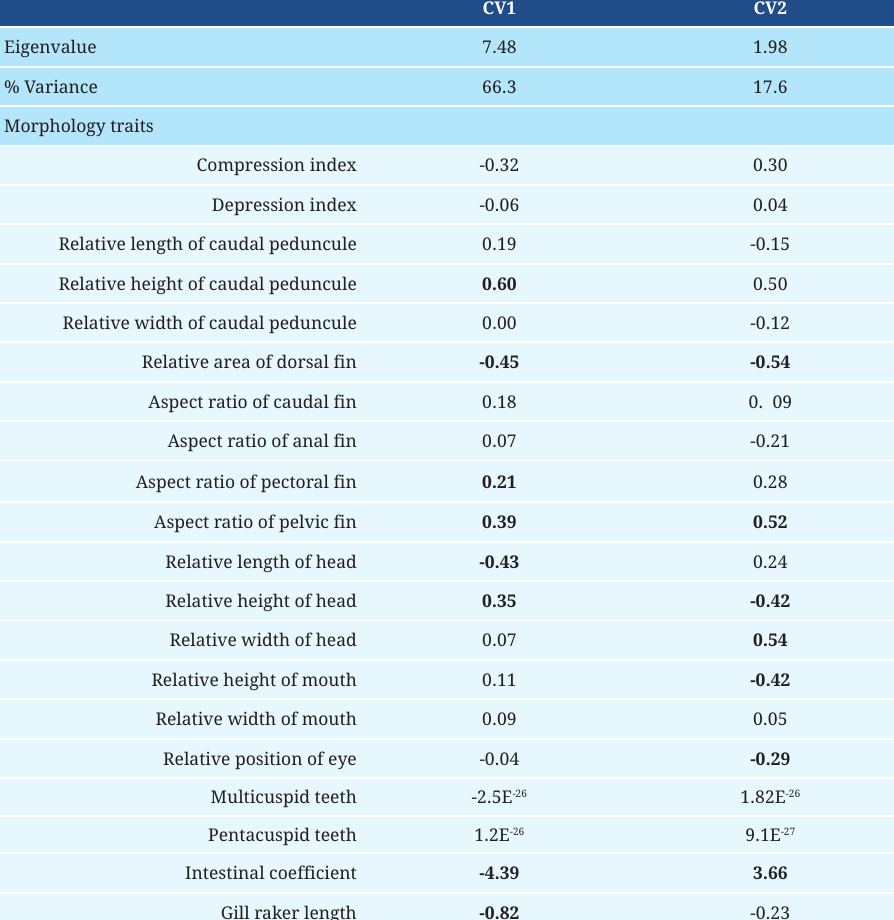
TABLE 3 | Results of the Canonical Variate Analysis (CVA) of the morphological traits for Serrapinnus notomelas and Serrapinnus sp.1 in a lake in the upper Paraná River floodplain, Brazil. The eigenvalues for each axis and the percentage of the variance explained by each of CV1 and CV2 are shown. The five highest positive and negative values of the morphological traits were highlighted in bold and selected for